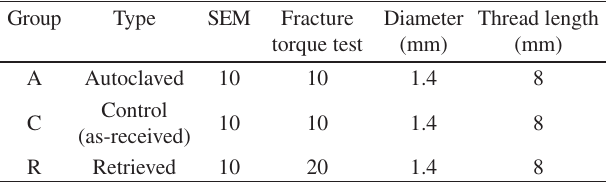
Table 1. Characterization of mini-implants groups tested. Group